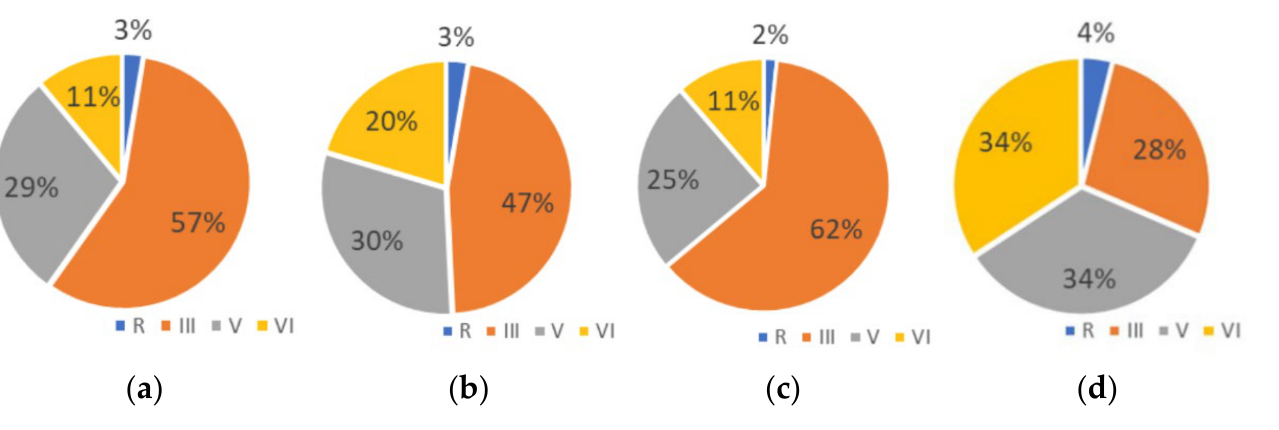
Figure 5. Graphite nodules classification by area (%) according to the classification of ISO-945 standard for each sample: ( a ) noP Un , ( b ) CP Un , ( c ) LCP Un and ( d ) TP Un , where III—Class III, V—Class V, VI—Class VI and R—remain classes.